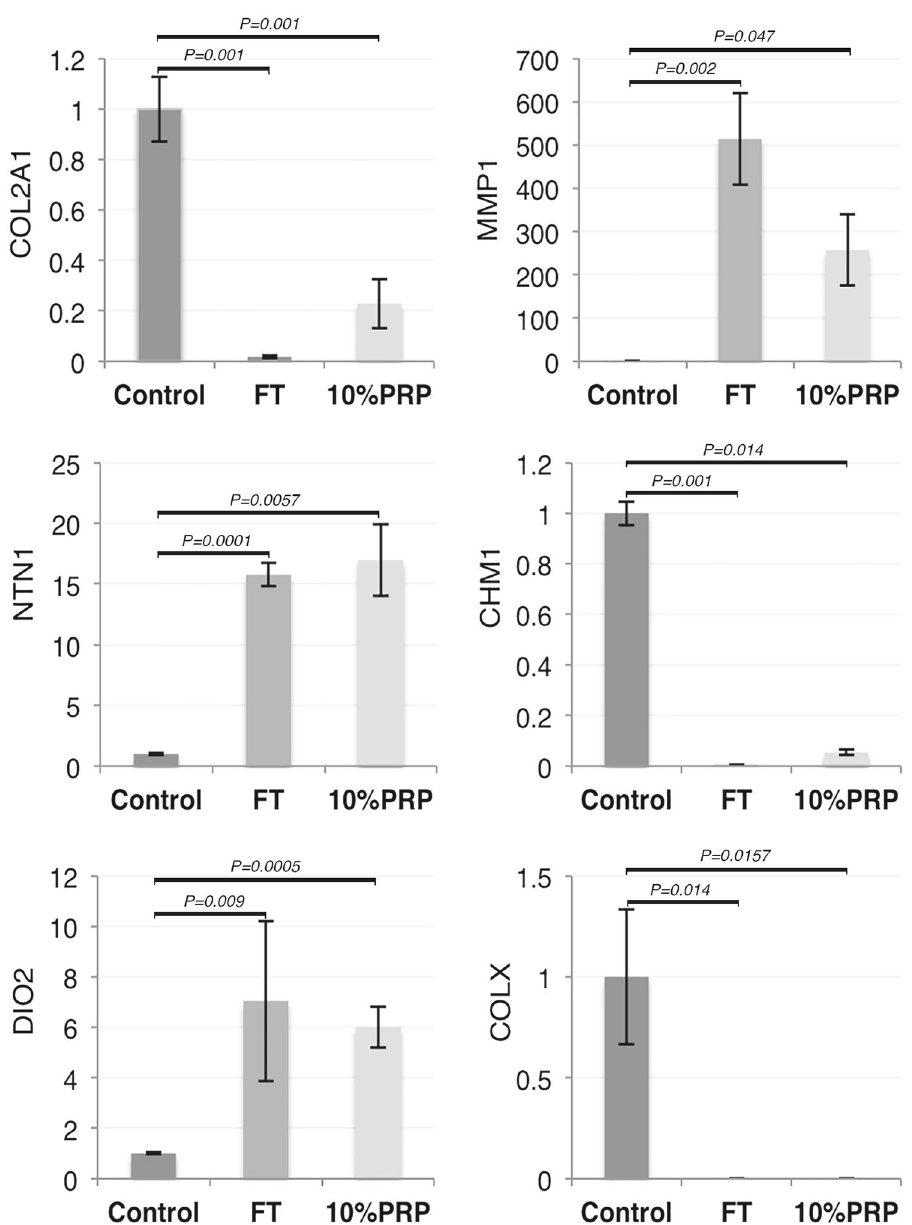
Figure 2. PRP lysate induces a maturation-like gene expression profile in immature articular cartilage. The relative fold change in gene expression of COL2A1, MMP1, NTN1, DIO2, CHM1 and COLX following growth factor or 10% PRP treatment are shown. Samples were tested after 14 days in culture (n = 4 for each group). Absolute quantitation (in ng) normalised to a 18S rRNA housekeeping gene was used to measure expression levels with the values converted to show relative-fold change in expression compared to untreated